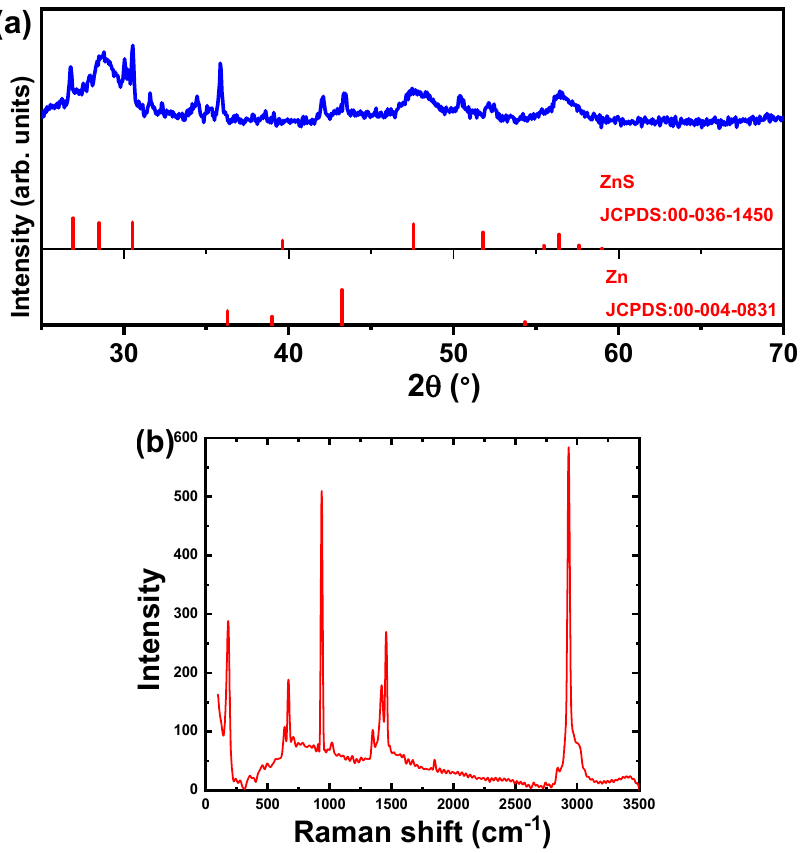
Figure 1. ( a ) XRD chart and ( b ) Raman spectrum of ZnS nanoparticles. Figure 2 displays SEM images of ZnS nanoparticles at different magnifications, 1500 Moreover, the structural parameters can be deduced from the XRD chart such as the and 3000 times, respectively, for Figure 2a,b. It is obvious from the SEM micrographs average crystallite size ( D ) that can be determined using the Scherrer equation [43,44]: that the ZnS nanoparticles are distributed in a relatively regular manner. The surface 𝐷 = (cid:2868).(cid:2877)(cid:3090) , where 𝜆 is the wavelength of radiation employed in Cu-K α (1.5406 Å), 𝛽 (cid:3035)(cid:3038)(cid:3039) (cid:3081) (cid:3283)(cid:3286)(cid:3287) (cid:3030)(cid:3042)(cid:3046)(cid:3087) morphology of ZnS samples is commonly seen to display two diverse morphologies such is the full width at half-maximum (in rad), and 𝜃 is the angle at the maximum peak’s as rods, or belts, together with inhomogeneous shapes. Furthermore, two colors, e.g., position (in rad). In addition, the micro-strain ( 𝜀 ) and the dislocation density ( 𝛿 ) can be bright and dark grey, may be detected, indicating the formation of two phases (cid:2868).(cid:2877)(cid:3090) + 4𝜀𝑠𝑖𝑛𝜃 , and evaluated from the modified Debye–Scherrer formula [44]: 𝛽𝑐𝑜𝑠𝜃 = (cid:3005) 𝛿 = (cid:2869) . For the investigated sample, the average crystallite size for Zn, and ZnS phases (cid:3005) (cid:3118) calculated using the Scherrer equation are equal to 54.5 nm, and 10.3 nm, respectively. The average micro-strain and dislocation density were estimated and found to be equal to 4.8 × 10 − 4 , 3.37 × 10 − 4 nm − 2 , and 1.8 × 10 − 3 , 9.4 × 10 − 3 nm − 2 for Zn and ZnS phases, respec- tively. Figure 1b depicts the Raman scattering spectrum for the chemical precipitated ZnS nanoparticles performed in air and at ambient temperature in the spectral range of 3500– 100 cm − 1 . The Raman spectrum shows that several frequencies and phonon mode assign- ments can be detected. For example, at 354 cm − 1 , there is a visible band that could belong to the second-order longitudinal optical mode. The third-order longitudinal optical mode is represented by a band that occurs at 1018 cm − 1 by a small peak. In addition, a small peak at 461 cm − 1 has been detected, which is correlated to longitudinal optical and longitudinal acoustic waves. There are other lesser peaks recognized as pure acoustic or optical modes, as well as combinations of these, in addition to this longitudinal optical peak. Higher- order combinations of these fundamental modes make up the wideband centered at about 630 cm − 1 . It is worth noting that the measurement acquisition time under near-resonant scattering is two to three orders of magnitude faster than under green excitation